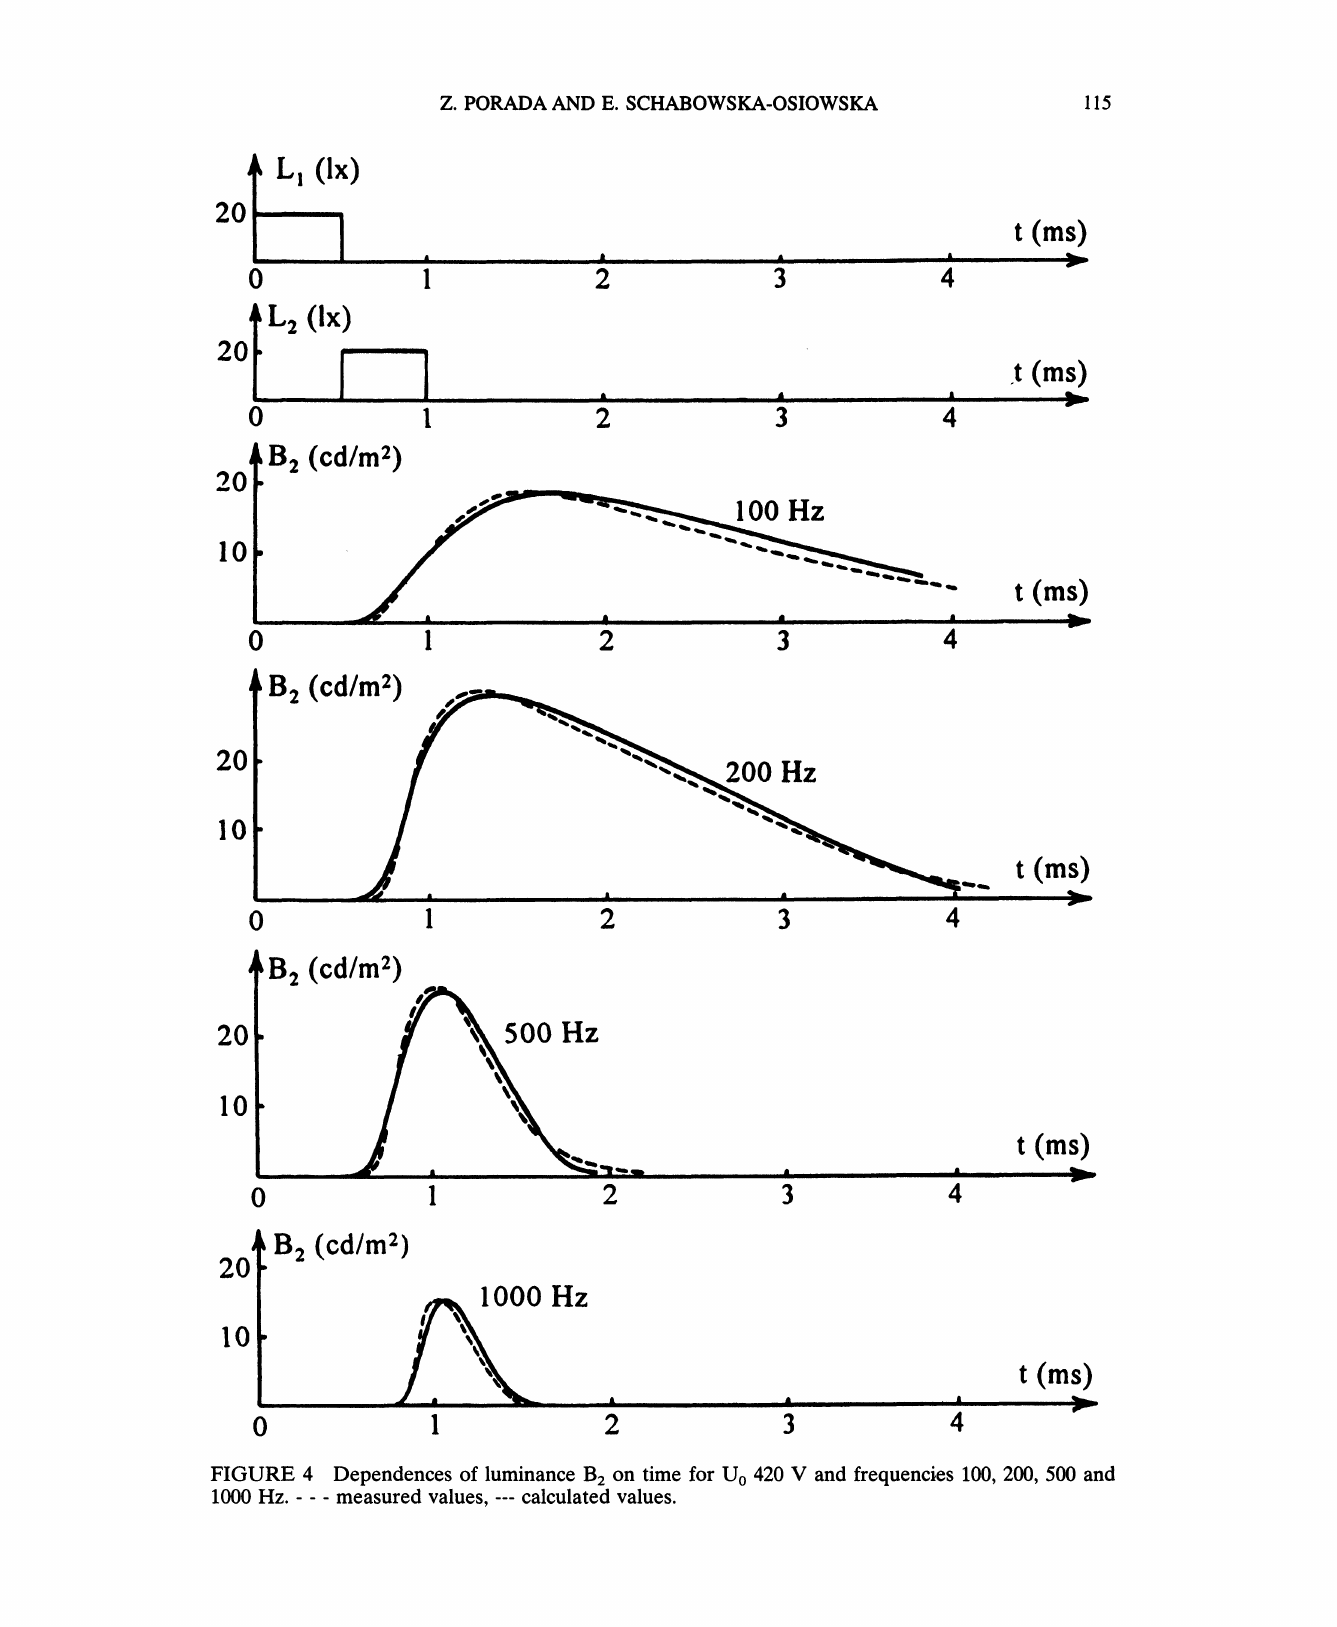
FIGURE 4 Dependences of luminance B on time for Uo 420 V and frequencies 100, 200, 500 and 1000 Hz. measured values, calculated